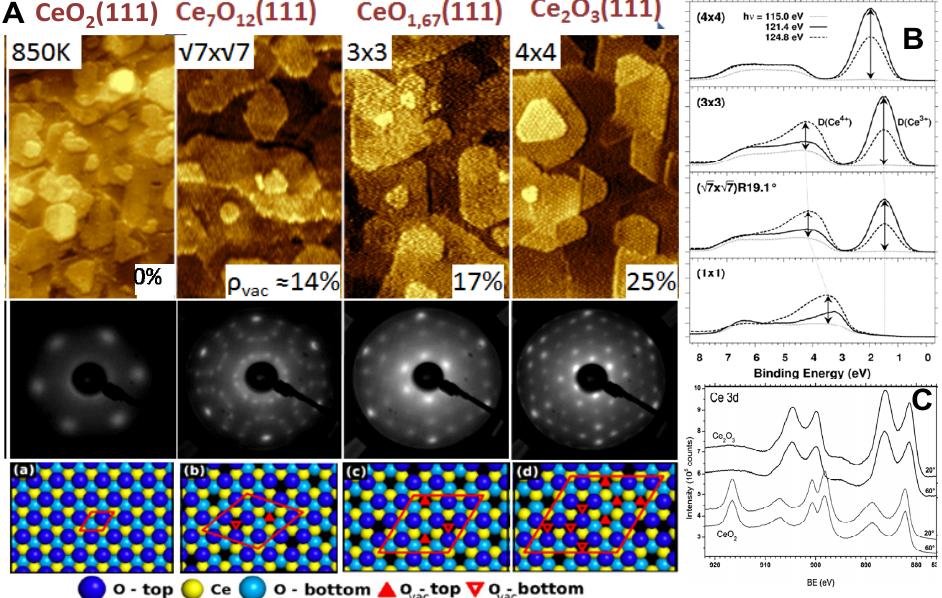
Figure 6. ( A ) STM, LEED and models illustrating the structure of cerium oxide films reduced via interface reaction of metallic Ce with the CeO 2 buffer layer. ( a ) CeO 2 ; ( b ) ι -Ce 7 O 12 ; ( c ) CeO 1.67 ; ( d ) c-Ce 2 O 3 Reduction of ceria with metallic Ce allows adjusting the concentration of oxygen vacancies between 0% and 25% [19]. Width of STM images 60 nm; ( B ) RPES spectra of the valence band of the ordered phases of stoichiometric and reduced ceria on Cu(111). The spectra are measured off-resonance (photon energy 115 eV, dotted lines), in the Ce 4+ resonance (124.8 eV, dashed lines), and in the Ce 3+ resonance (121.4 eV, full lines). The resonance enhancements D (Ce 3+ ) and D (Ce 4+ ) are indicated by arrows [19]; ( C ) XPS of cerium oxide before (thin lines) and after (thick lines) the reaction between Ce and CeO 2 buffer layer. The Ce 3d core-level spectra were taken at two different emission angles indicating no changes in the stoichiometry of cerium oxide with information depth [49] .